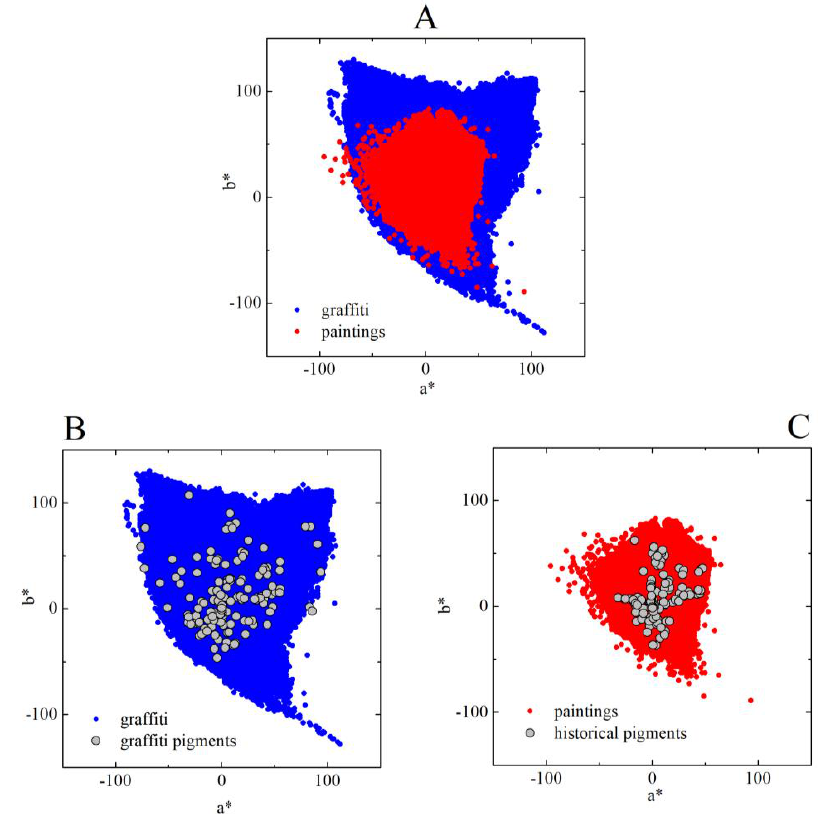
Figure 5. ( A ) Full color gamut obtained from the analysis of 228 graffiti (blue) and 44 paintings (red). ( B ) Gray circles in represent the colors of 150 samples of pigments used in graffiti. ( C ) Gray circles represent the colors of 54 historical pigments commonly used in paintings. The colors of the both types of pigments were obtained assuming standard illuminant D 65 . Graffiti show more saturated colors due to the new generation of artificial pigments.